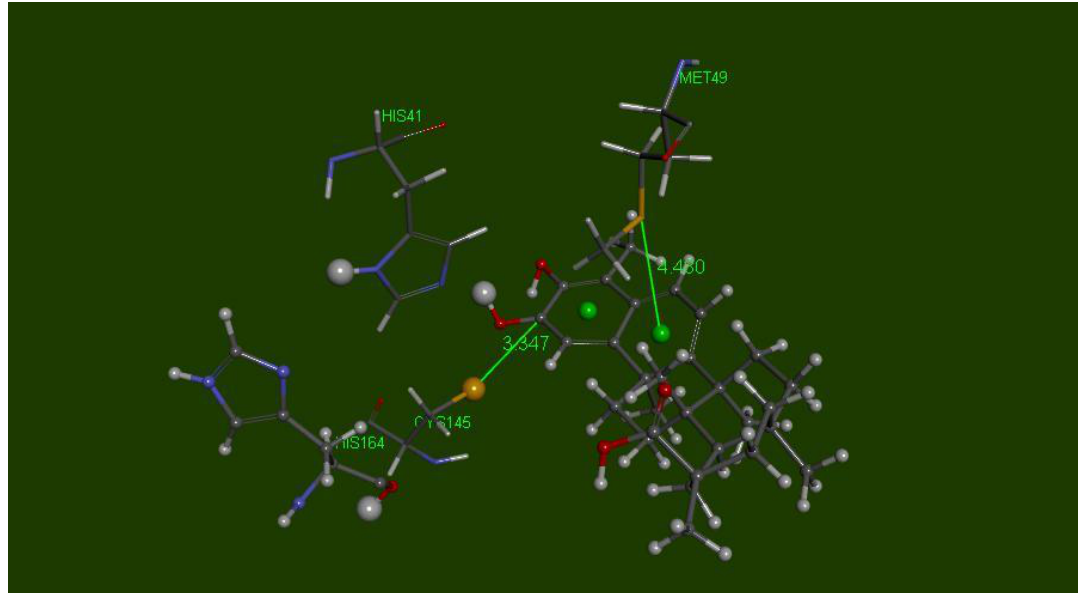
Figure 15. This shows O=C(Celastrol) capture of H(imidazole-His41) forming a positively charged HOC(celastrol) moiety, and the Cys145 S-H cleavage due to proton capture by O(His164) forming HO(His164). After rotating the Cys145 torsion angle C-C-C-S, the S(thiolate) gets closer to the former celastrol C(carbonyl), 3.347 Å, to form a S-C covalent bond.